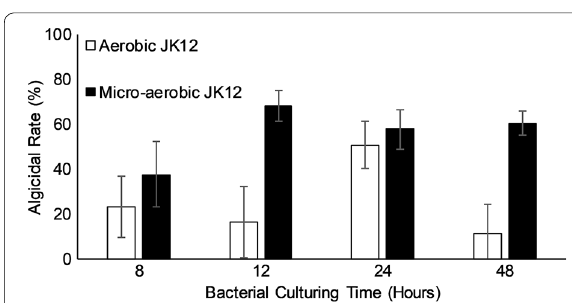
Fig. 5 Effects of the bacterial supernatant on algae death rate of P. tricornutum at different time-points. All error bars indicate the SD of the three biological